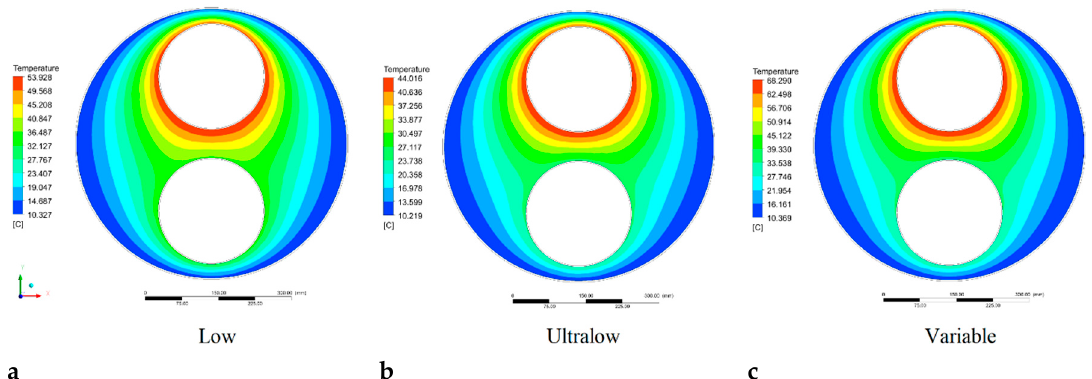
Figure 4. The effect of the grid size on length direction on the accuracy of the results.